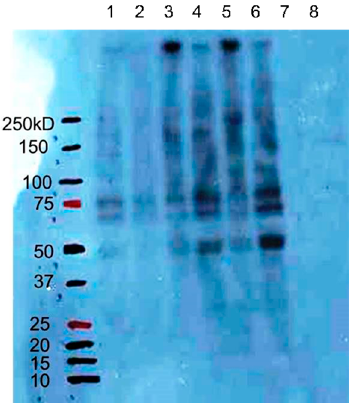
Figure 3. Effects of GeOH on TGase activity in cultured epidermal keratinocytes. HaCaT cells were cultured for 3 days in medium supplemented with or without (control) 10 or 100 µ g/mL GeOH, and the activity of TGase was determined by Western blotting with biotin-bound pentylamine when the same amount of proteins was loaded. Lanes 1 and 2 are controls, lanes 3 and 5 are 10 µ g/mL GeOH, lanes 4 and 6 are 100 µ g/mL GeOH, and lanes 7 and 8 are biotin ( − ). Biotin ( − ) represents the samples incubated without biotin-bound pentylamine.